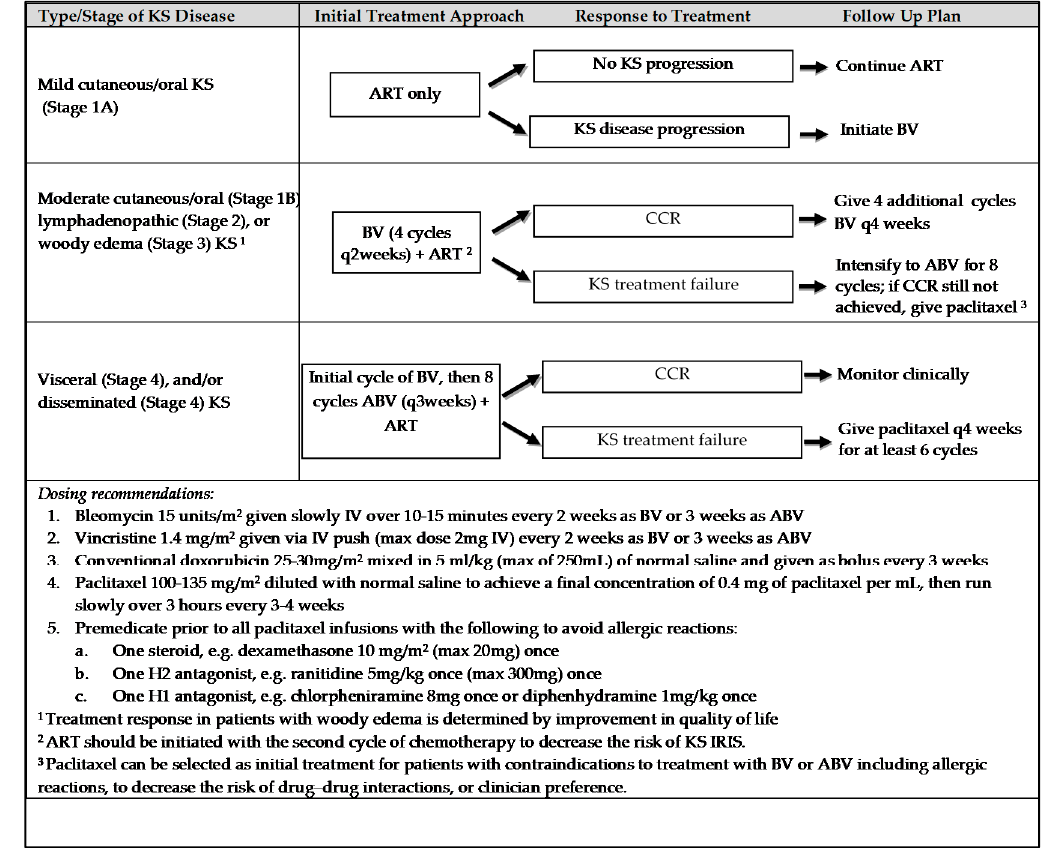
Figure 1. Treatment algorithm for pediatric and adolescent patients with Kaposi sarcoma. Adapted from the risk-stratified and response-adapted therapeutic approach to pediatric Kaposi sarcoma [18] and recommended chemotherapy plan for KS in pregnancy in resource limited settings [21]; Abbreviations: ART—antiretroviral therapy; KS—Kaposi sarcoma; BV— bleomycin + vincristine; ABV—doxorubicin + bleomycin + vincristine; CCR—complete clinical remission; IRIS—immune reconstitution inflammatory syndrome; IV—intravenous.